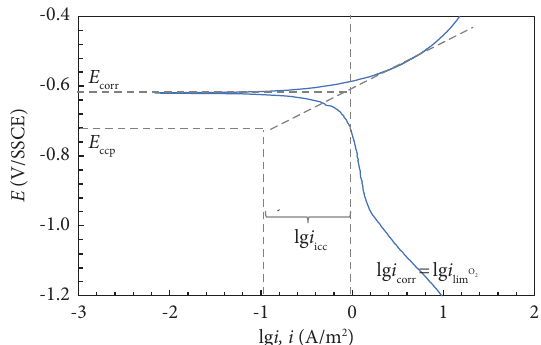
Figure 1: Corrosion diagram of steel in tap